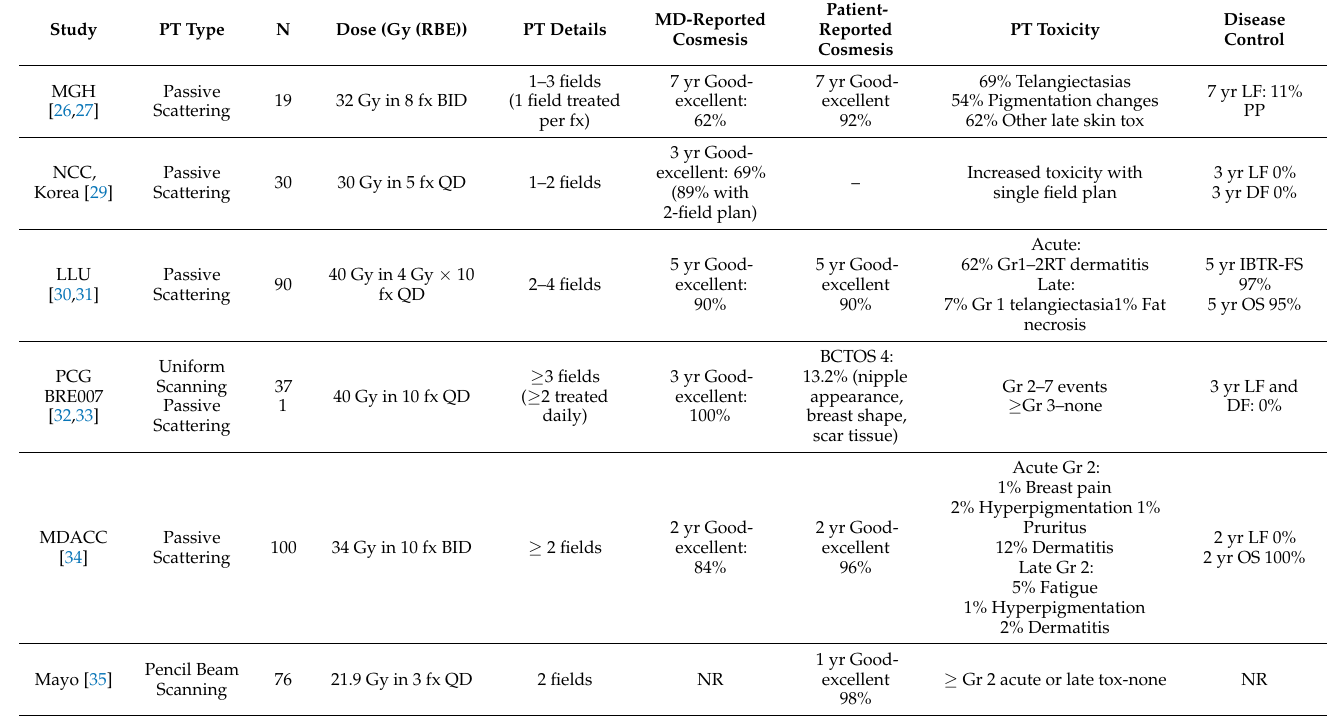
Figure 1. Proton and Photon Partial Breast Irradiation Treatment Plans. This is a patient with a left-sided breast cancer receiving partial breast irradiation. The left image is a representative axial slice of a proton plan using two treatment fields (anterior and left anterior oblique). The right image is a representative axial slice of a photon static-field intensity-modulated radiation therapy (IMRT) plan using 4 fields (right anterior oblique, anterior, left anterior oblique, and left posterior oblique). Table 1. Prospective investigations of partial breast irradiation (PBI) with proton therapy